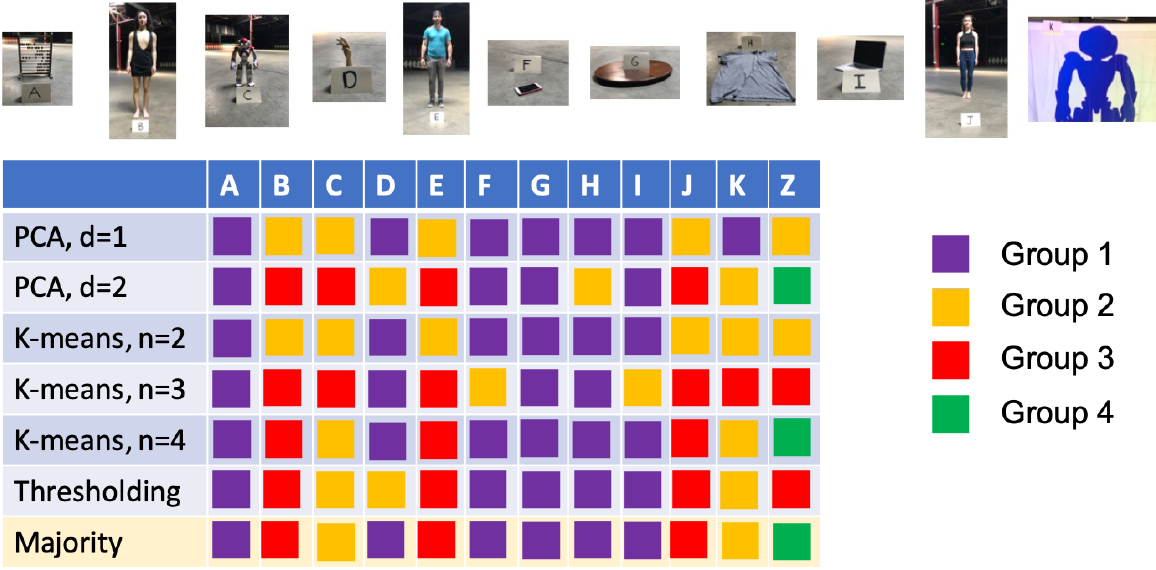
Figure 6: Average Expressivity Rating of all participants (Pre-Survey, Mid-Survey, and Post-Survey) for each System in Performance 4. Or- dered by increasing overall average expressivity rating, humans (specifically Self) emerged as the highest rated followed by the humanoid elements used in the show (the NAO and NAO Shadow).